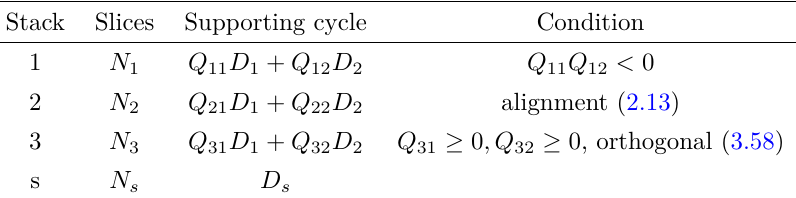
Table 1 . Axionic brane configuration. We choose D7-branes such that we can have multiple slices, with N I branes in each